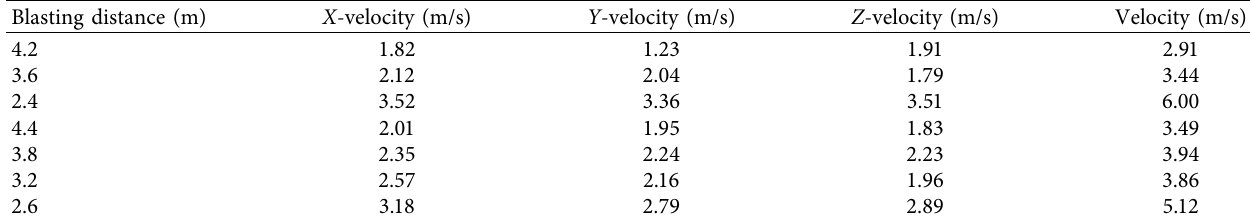
Table 2: Monitoring location and results of near-field blasting vibration.